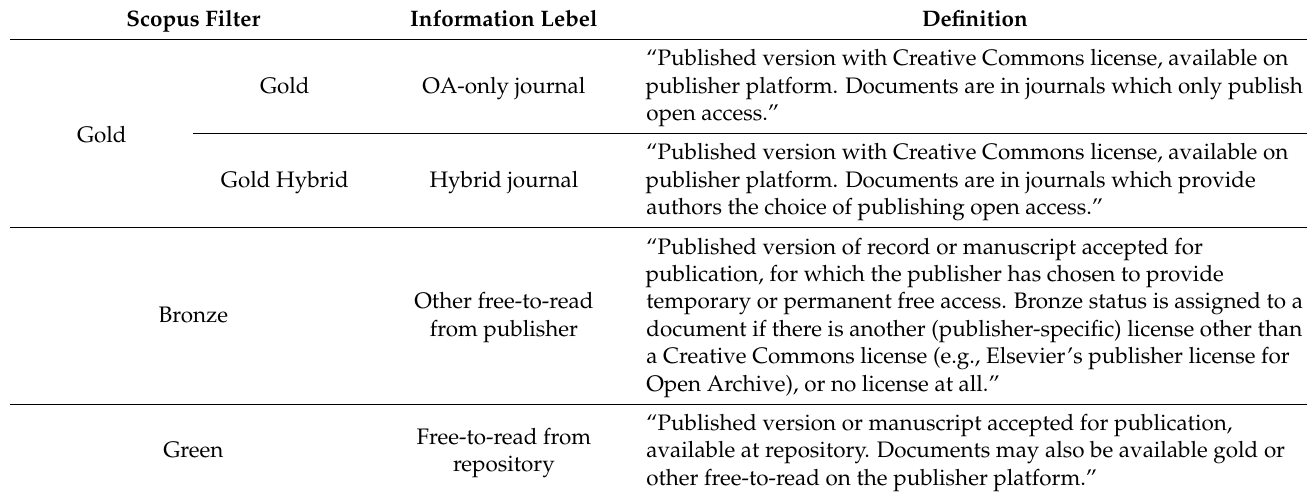
Table 4. Descriptions of open access types in Scopus.